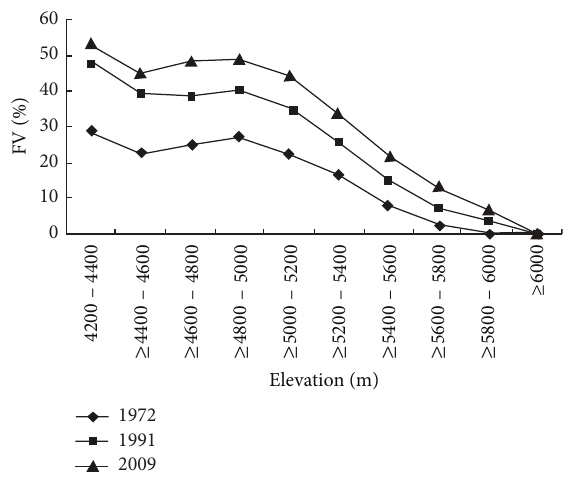
Figure 6: The mean vegetation cover fraction along the altitude gradient in 1972, 1991, and 2009.